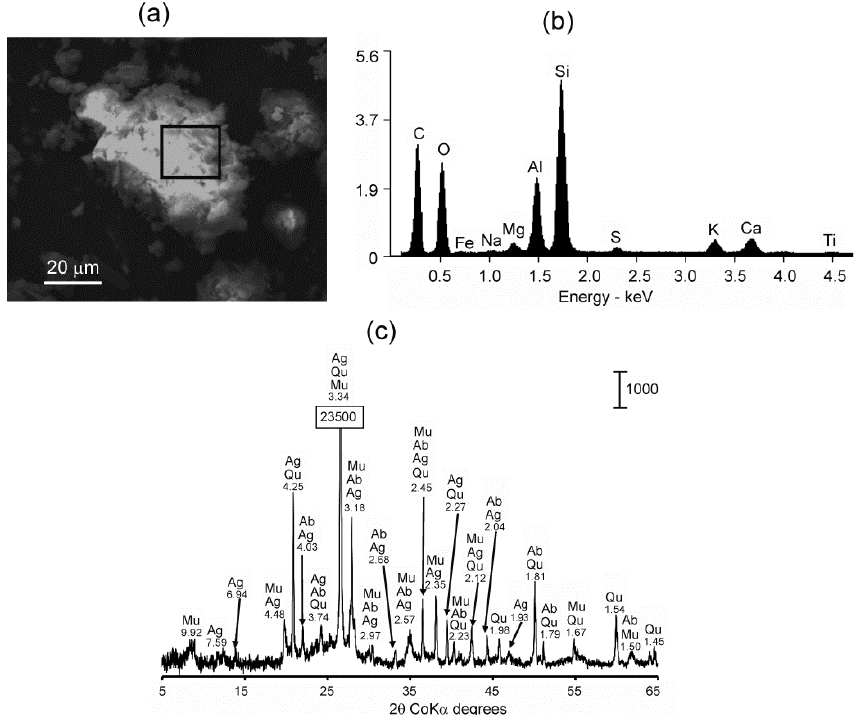
Figure 2. Characteristics of the chemical composition of the RBS38 sample. Scanning electron micrograph ( a ), the corresponding EDS spectrum ( b ), and the X-ray diffractogram showing the mineralogical composition ( c ). The vertical bar in ( b ) shows the scale of relative counts. Letter codes: Qu— quartz, SiO 2 , Ag —alunogen, Al 2 (SO 4 ) 3 ·17H 2 O, Ab —albite, NaAlSi 3 O 8 , Mu —muscovite,